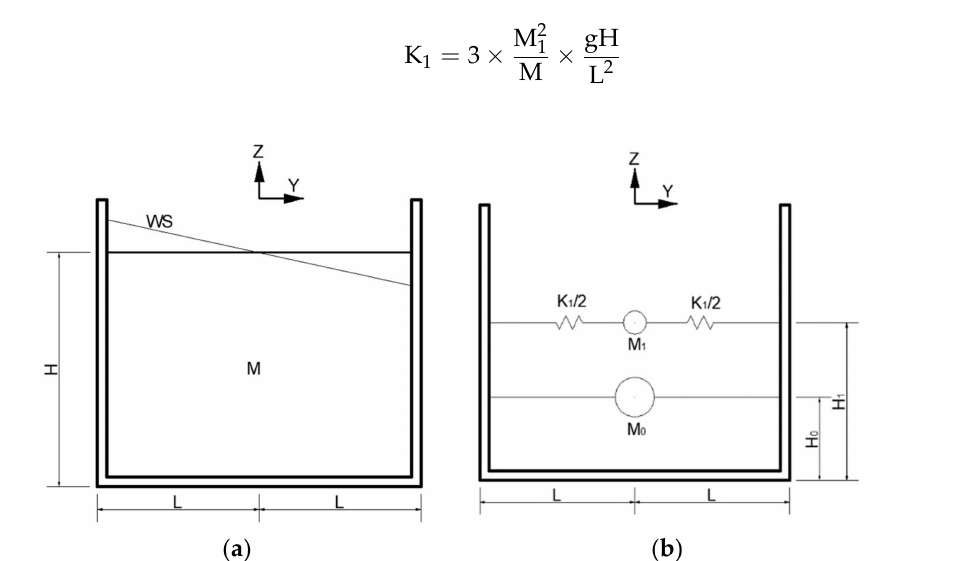
Figure 3. ( a ) Sloshing diagram of a tank; ( b ) equivalent dynamic system for a water tank.